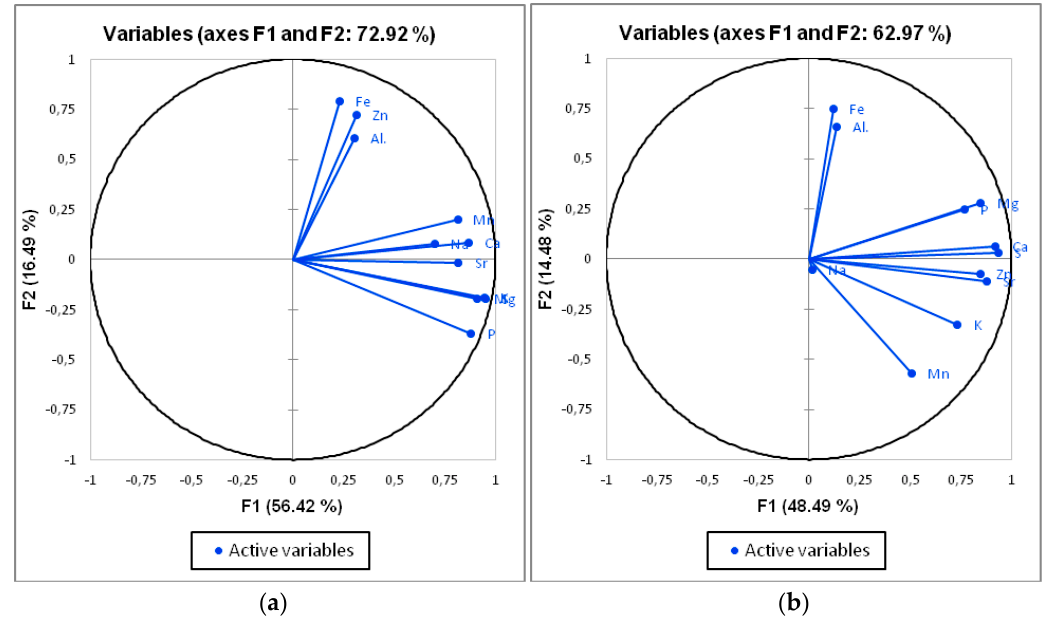
Figure 7. Graph presenting variables in a system of two initial factorial axes for basket willow biomass at the end of the first ( a ) and second ( b ) years of cultivation.